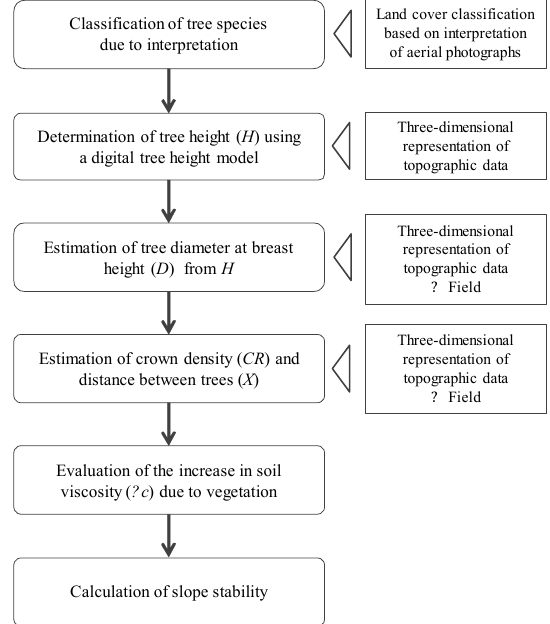
Figure 3. Flowchart of the method used to estimate changes in Δ c